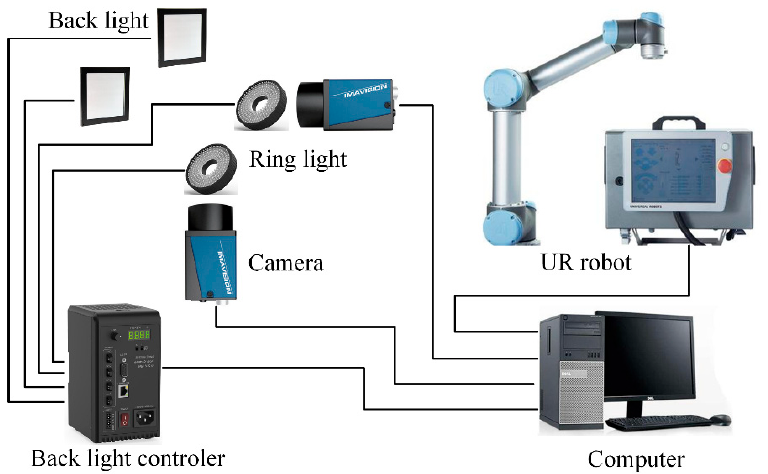
Figure 1. System